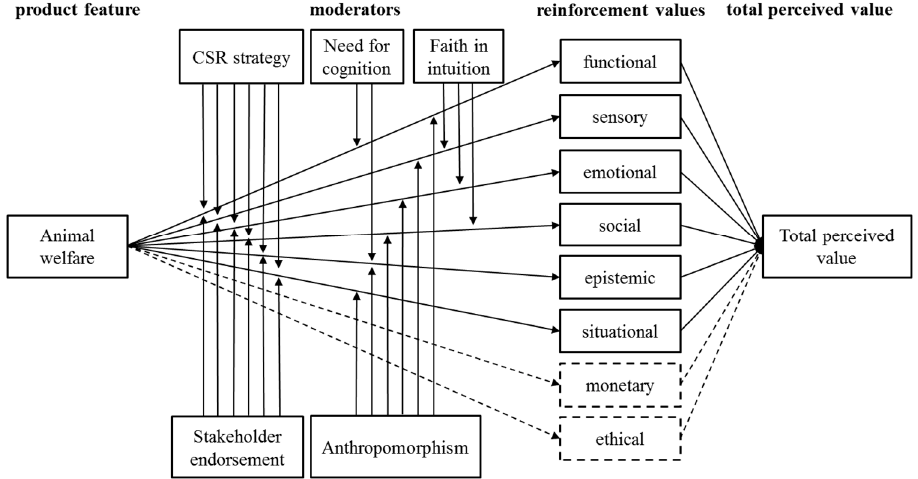
Figure 3. Full conceptual model. The dashed arrows and constructs represent the existing associations of animal welfare with the monetary and the ethical value, which do not represent reinforcement positioning strategy.